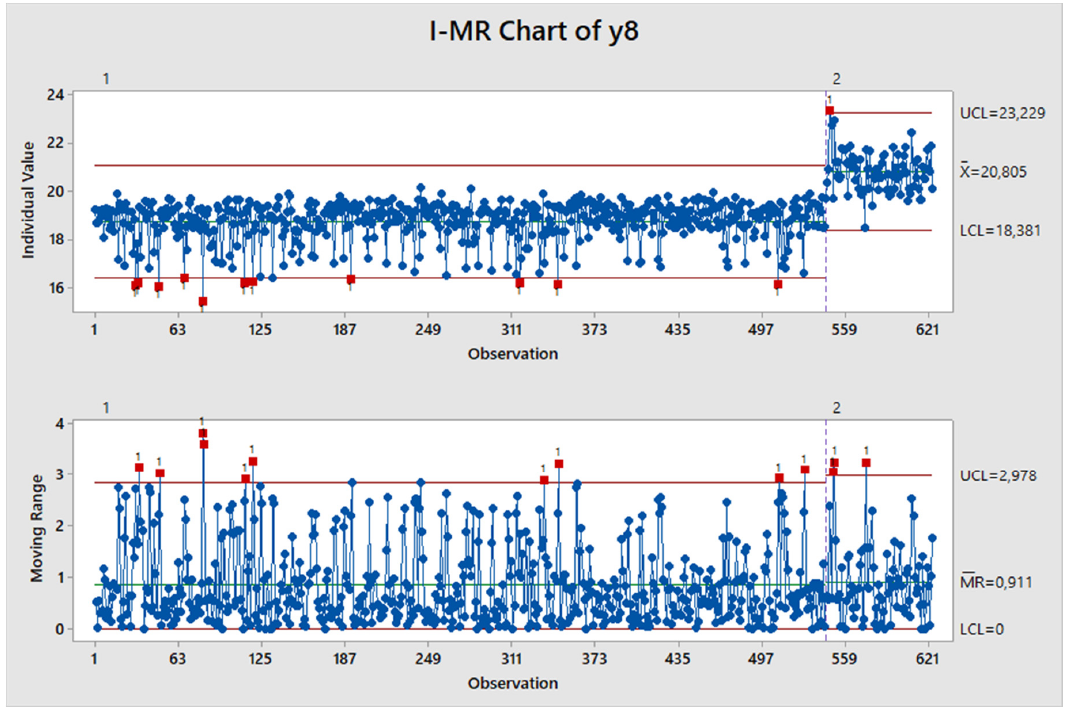
Figure 13. Individual-Moving Range (I-MR) control chart for variable y 8 , for batches where Premix 2 was fed into the reactor, before (1) and after (2) improvement in accordance to the conclusions of the Six Sigma project.